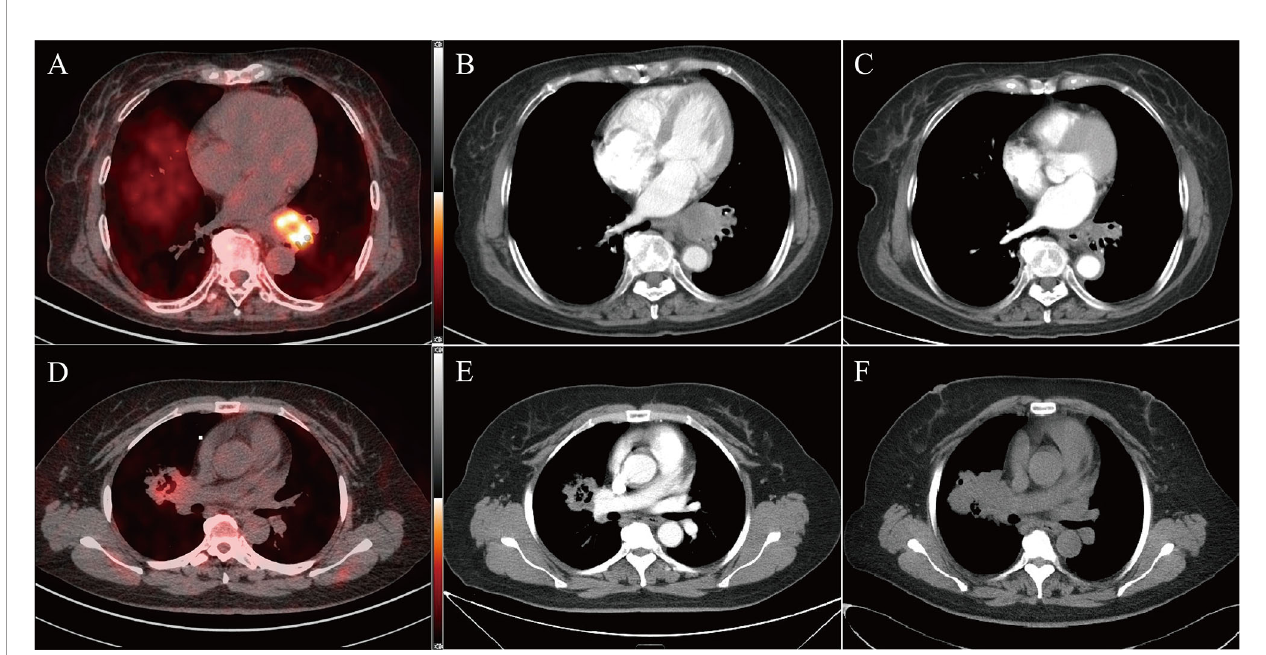
FIGURE 2 | Two typical examples of 18 F-RGD PET/CT scans in responder (top panel, SUVmax = 7.99, SUVmean = 3.39, MTV = 5.02, Response evaluated as PR) and non-responder (bottom panel, SUVmax = 3.38, SUVmean = 2.76, MTV = 2.07, Response evaluated as PD). Baseline PET/CT images (A, D) and corresponding CT slices from before treatment (B, E) and 2 cycles after treatment (C, F) .